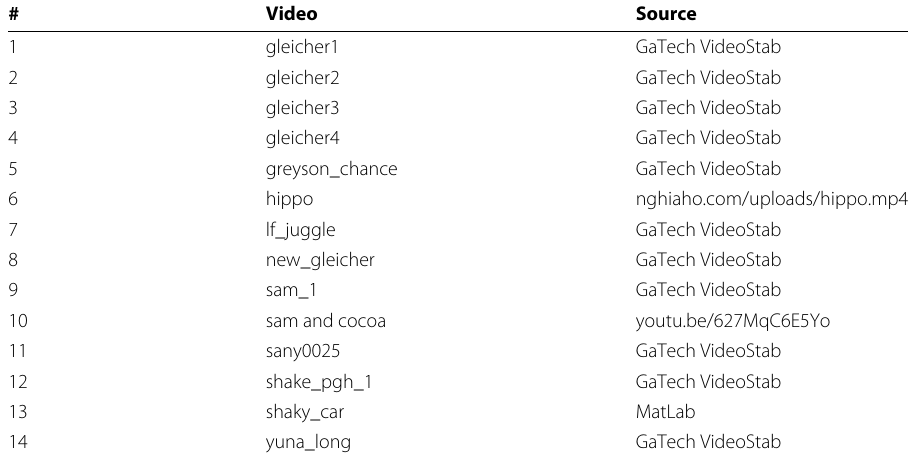
Table 1 Video sequences from the first